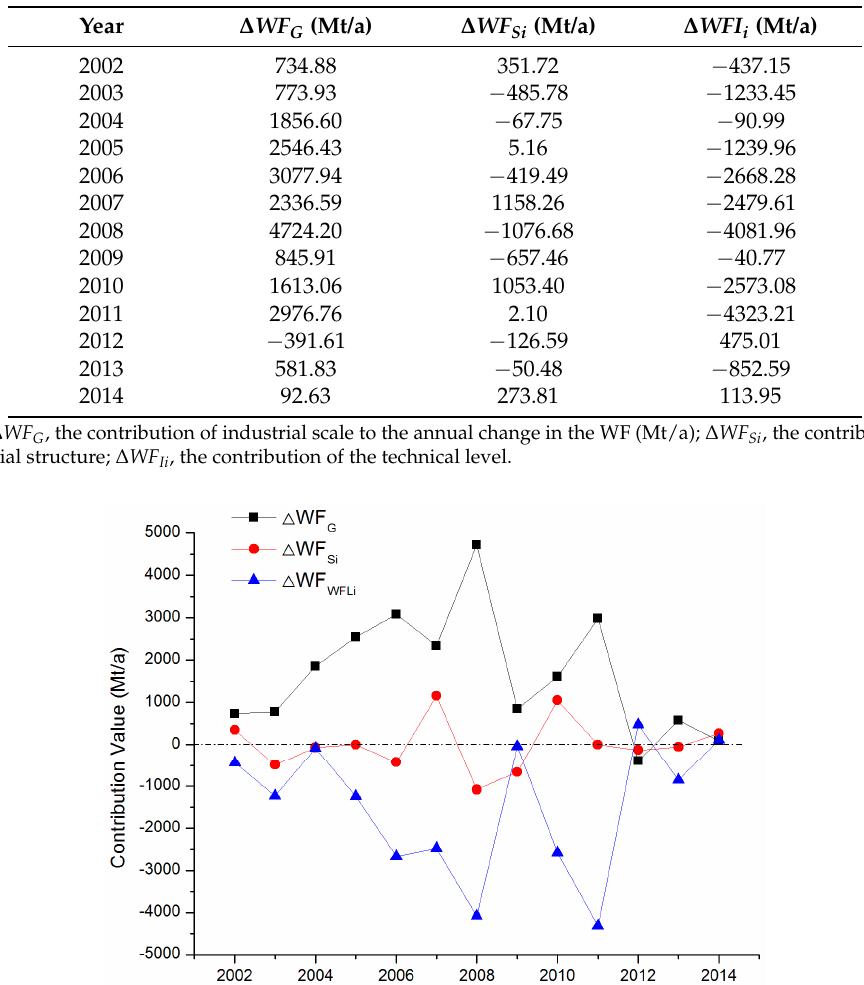
Table 5. Decomposition analysis of WF factors for China’s textile industry, 2002–2014.